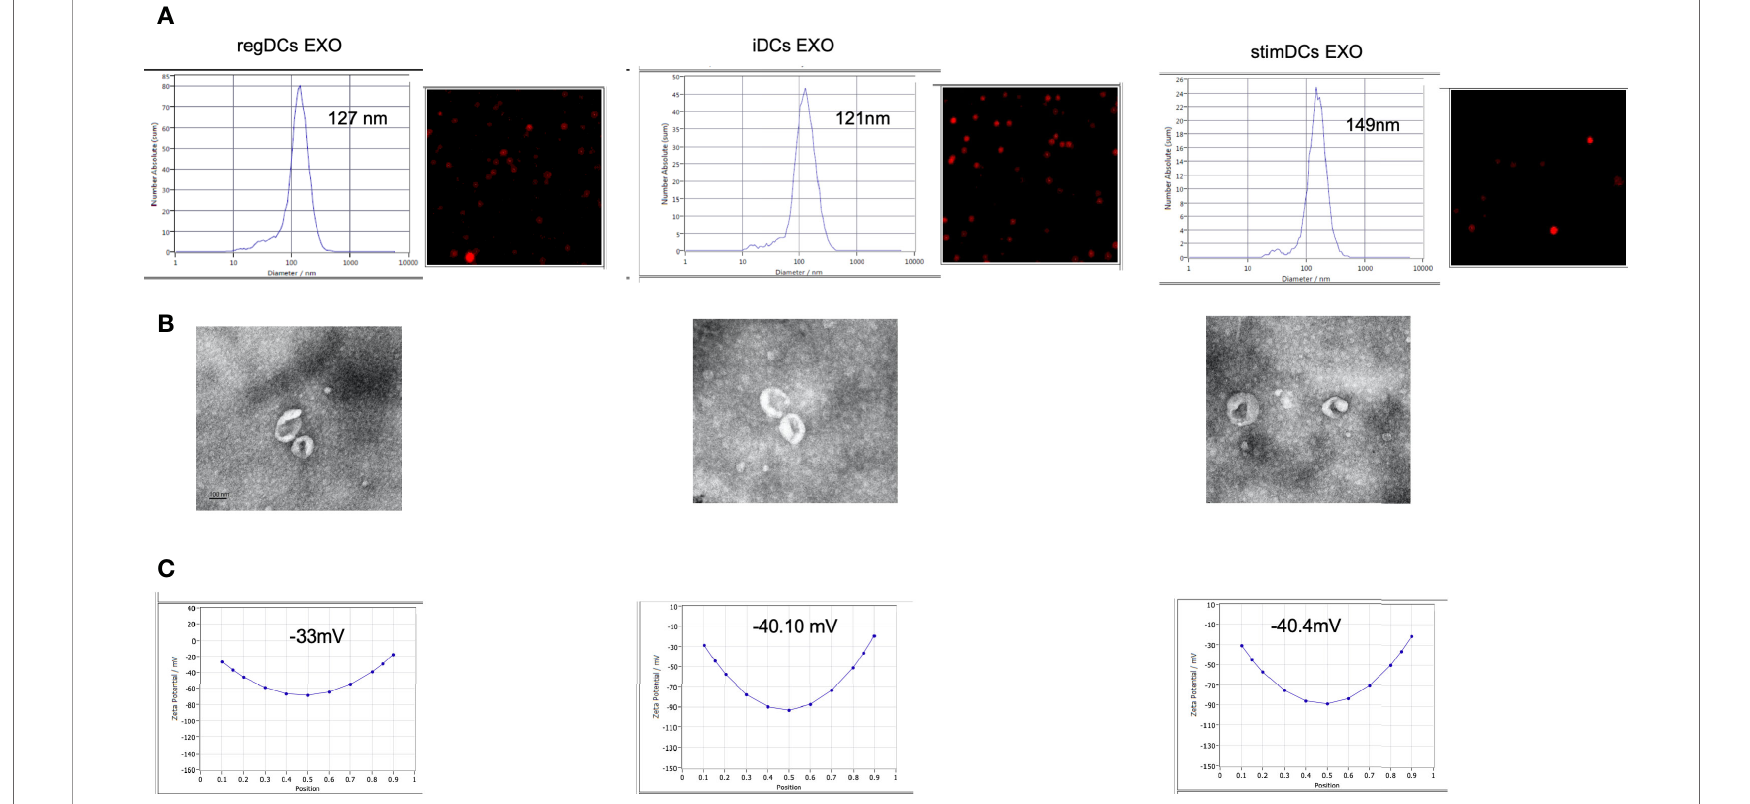
FIGURE 1 | (A) Nano-tracking analysis to determine EXO number and size distribution in nm. (B) Transmission electron microscopy (TEM) to visualize EXO shape and size. (C) Zeta potential analysis to determine EXO surface charge. regDCs EXO (Left), iDCs EXO (middle) and stimDCs EXO